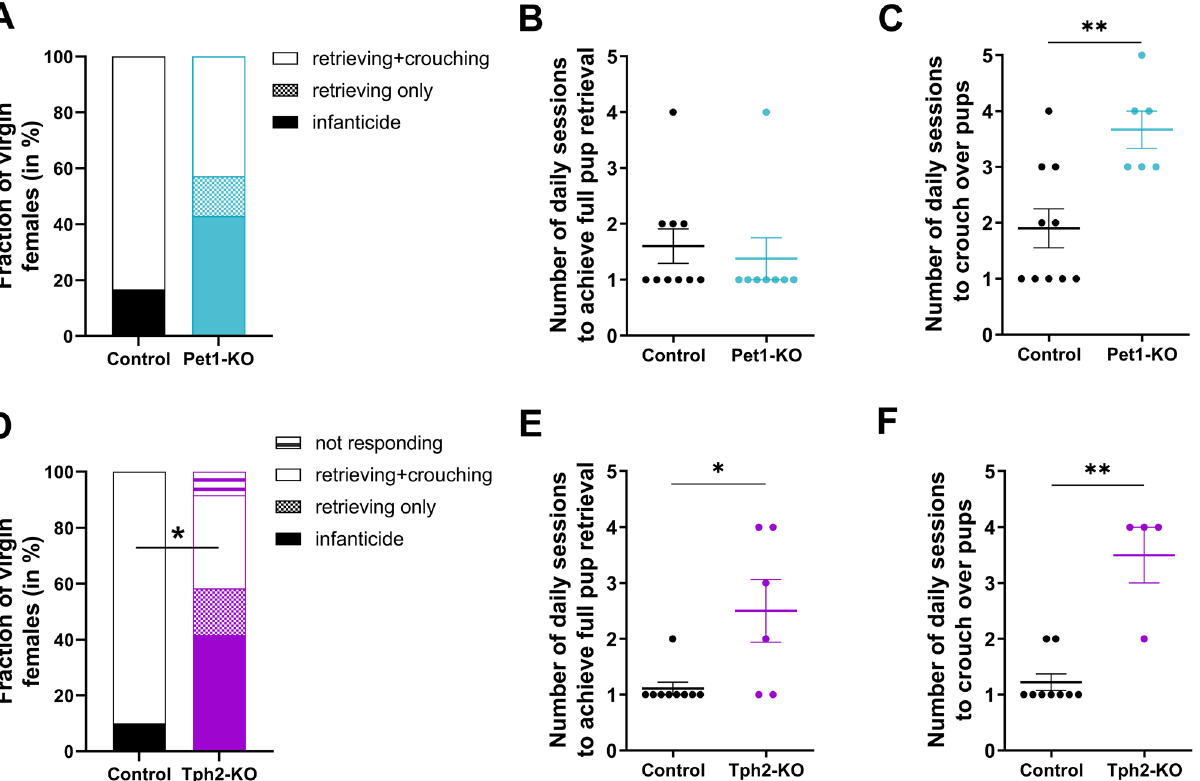
Figure 4. 5-HT depletion is associated to a delayed initiation of crouching behavior onto pups in virgin mice. Virgin ( A–C ) Pet1-KO (n = 14) and ( D–F ) Tph2-KO (n = 12) females and their littermate controls (n = 12 Pet1 +/− and n = 10 Tph2 +/+ ) were individually exposed in their home cages to three 1- to 4-day-old C57BL/6 pups. Training session lasted for 30 min and were repeated daily up to 4 or 5 days. ( A,D ) Histograms showing for each genotype, the distribution (in %) of the females at the end of the procedure in the following categories: infanticidal, not responding, retrieving only, or retrieving + crouching. ( A ) Although there was a tendency for infanticide by Pet1-KO virgin females, the statistical comparison showed no significant differences (Chi- square test). ( D ) A smaller number of Tph2-KO females showed crouching behavior compared to control dams. * p < 0.05 (Chi-square test). ( B,E ) Graphs showing the number of daily sessions required to retrieve the 3 pups. Infanticidal and not responding females were excluded from these quantifications. ( B ) Number of sessions required to retrieve 3 pups was similar between Pet1-KO and control virgin mice, with the majority being able to complete the task from the first session. ( E ) Tph2-KO females required more sessions than control mice to retrieve 3 pups, * p < 0.05 (mean ± SEM, Mann–Whitney test). ( C,F ) Graphs showing the number of daily sessions required by the females that performed retrieval followed by crouching over at least 2 pups continuously for more than 1 min. Both retrieving ( C ) Pet1-KO and ( F ) Tph2-KO virgin mice required more daily sessions to show crouching behavior, compared to their respective controls, ** p < 0.01 (mean ± SEM, Mann–Whitney dams. No differences between DRN control and DRN TPH2−CKO were observed in nest building (supplementary Fig. 5A), pup retrieval (supplementary Fig. 5B), or in nursing time (supplementary Fig. 5C). Because the extent of stereotaxic viral injections and consequent 5-HT depletion can vary across cases and thus generate phenotypic heterogeneity, we performed a histological examination of the DRN (Fig. 5C,D). In each case, serial sections were immunostained for GFP, to visualize the site of injection, and for TPH2 and 5-HT to evaluate the efficiency of recombination in different raphe subregions. In all cases, GFP positive (GFP +) cells were present in the DRN indicating successful viral delivery. Counting of TPH2-immunoreactive neurons in the DRN TPH2−CKO showed a 77.8% reduction (range: from 29.7 to 99.6%) when compared to DRN control mice (MW U = 8, p < 0.0001, Fig. 5B,C1–D1) Accordingly, a strong reduction of 5-HT immunolabeling was observed in the DRN of the DRN TPH2−CKO mice (Fig. 5C2–D2) while TPH2 and 5-HT co-labeling was unchanged in the MRN indicating that recombination affected selectively the DRN (Fig. 5D1–D2). We then evaluated how the extent of 5-HT depletion and the time dedicated to nursing could affect pup survival. Since pup survival had a dichotomous distribution (0% or 80–100%), point-biserial correlations were run. Pup survival from DRN TPH2−CKO dams significantly correlated with the number of TPH2 + cells in the DRN (Kendall’s tau r = 0.458, p = 0.036; Fig. 5E) as well as with the nursing time (Kendall’s tau r = 0.68, p = 0.003; Fig. 5F). Such correlations were not found in the DRN control group (Fig. 5E,F) . In addition, the number of TPH2 + cells in the DRN and the nursing time were also correlated (spearman r = 0.4, p = 0.05; supplementary Fig. 5D). These data indicate that despite